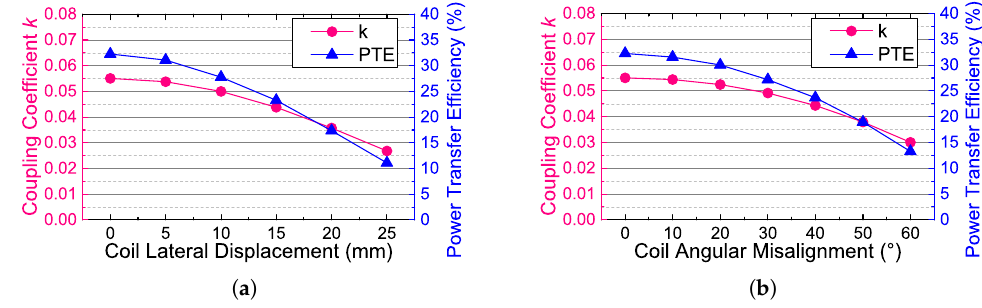
Figure 18. The coupling coefficient and the power transfer efficiency versus ( a ) coil lateral misalignments and ( b ) coil angular misalignments when the coil separation d = 20